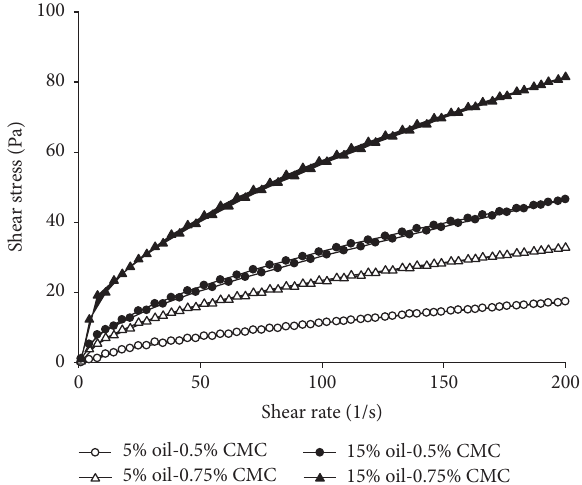
Figure2:FlowcurvesofO/Wnanoemulsionswithdifferentoil(5%: empty symbols and 15%: filled symbols) and CMC concentration (0.5%: circle and 0.75%: triangle).